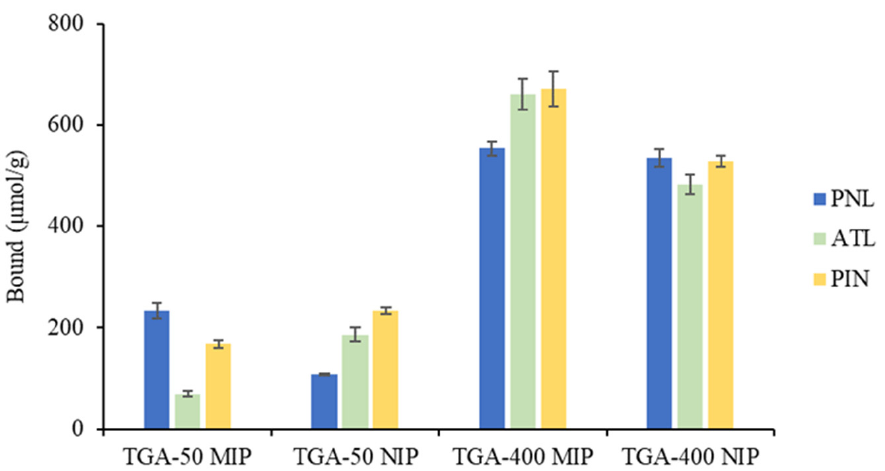
Figure 4. Cross-binding results for the TGA-50 and TGA-400 PNL MIPs and NIPs against atenolol (ATL) and pindolol (PIN). A total of 2 mg of polymer was incubated in 1.0 mL of 2 mM analyte solution for 2 h. All binding tests were conducted in triplicates for each of the four batches of poly-